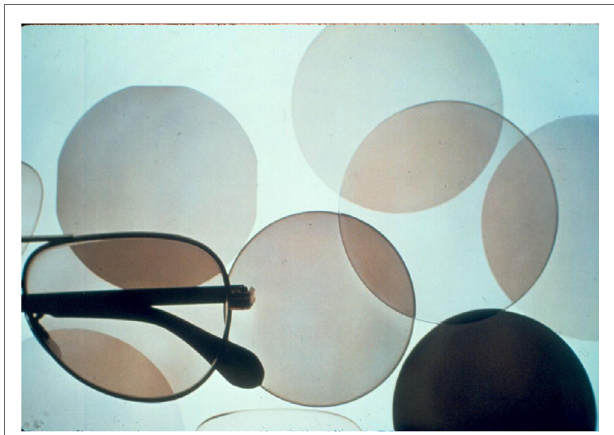
FiGURe 10 | Photochromic eye-glasses (1960s) .